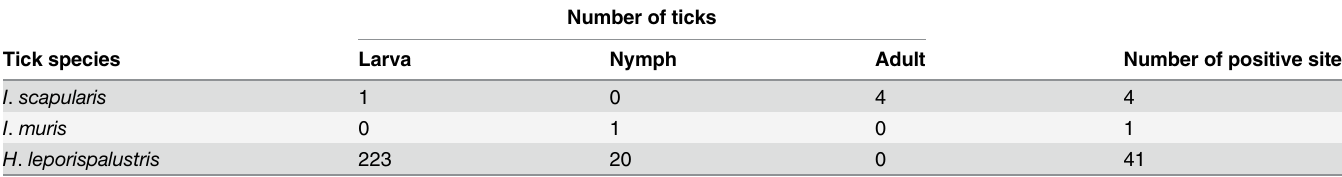
Table 2. Numbers of ticks of each species and instar collected during the study. Note that all adult ticks were males.